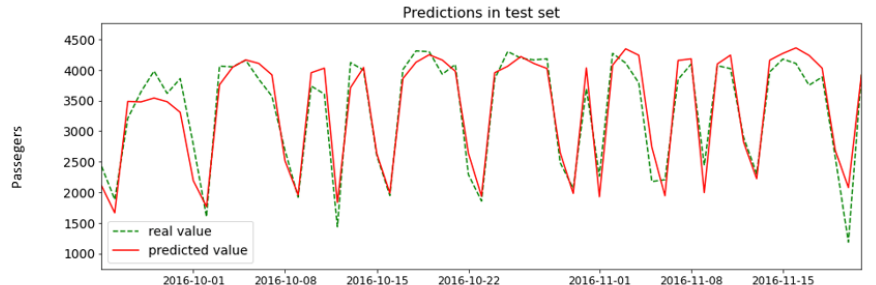
Figure 8. Zoom-in of the prediction in the test set. Dashed green: real value. Solid red: prediction.